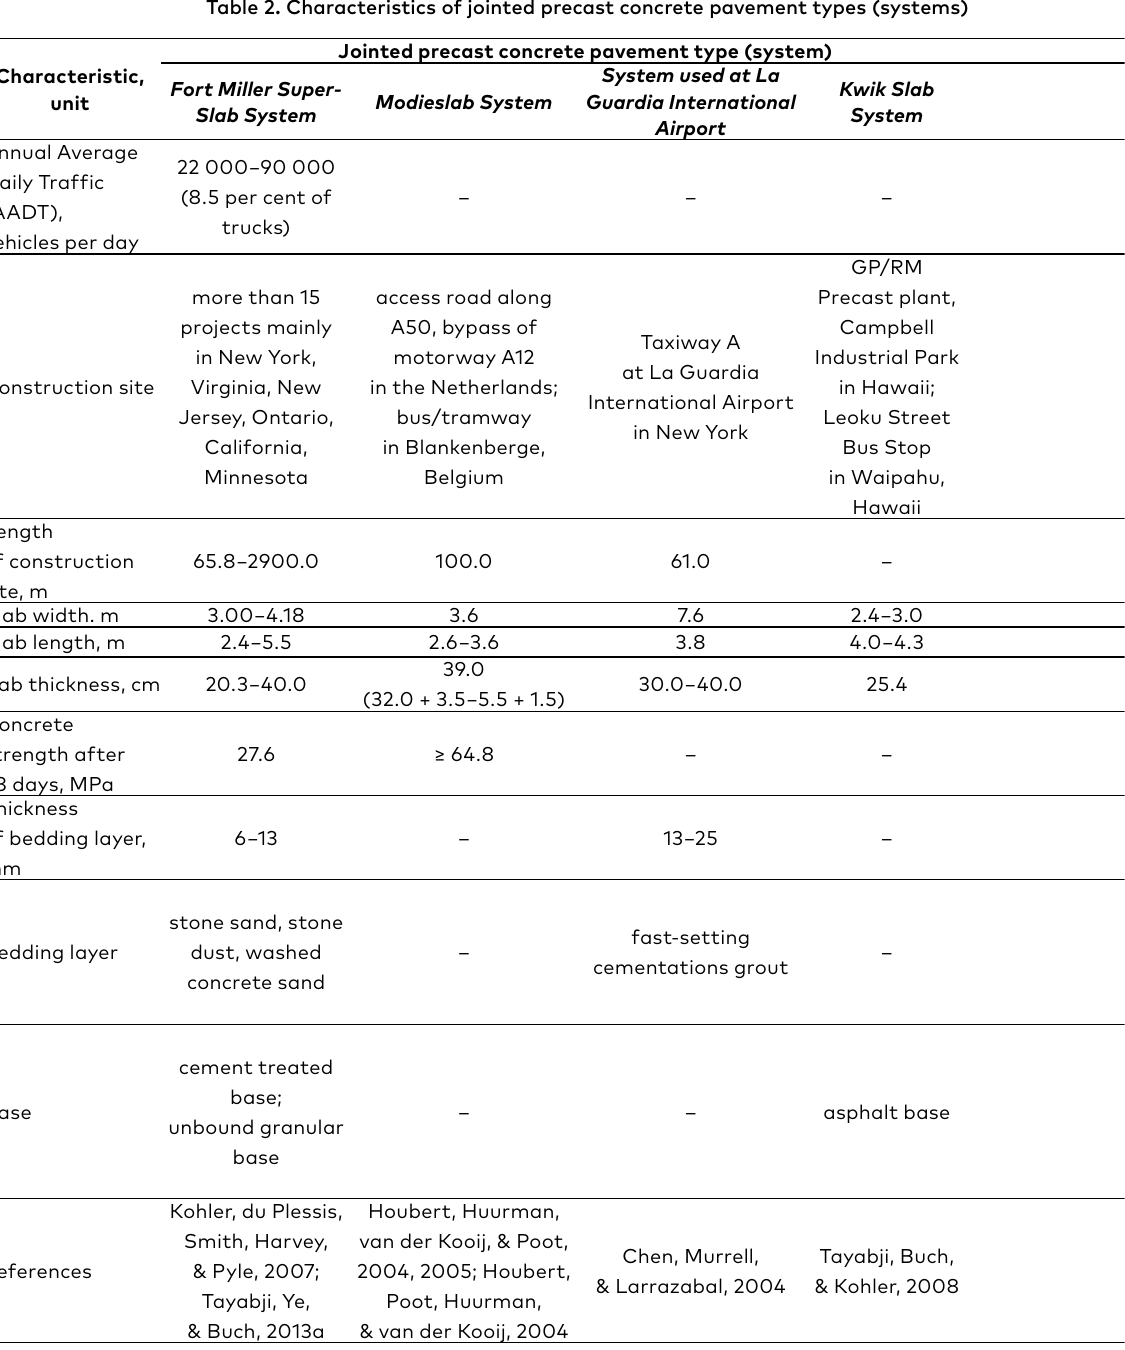
Table 2. Characteristics of jointed precast concrete pavement types